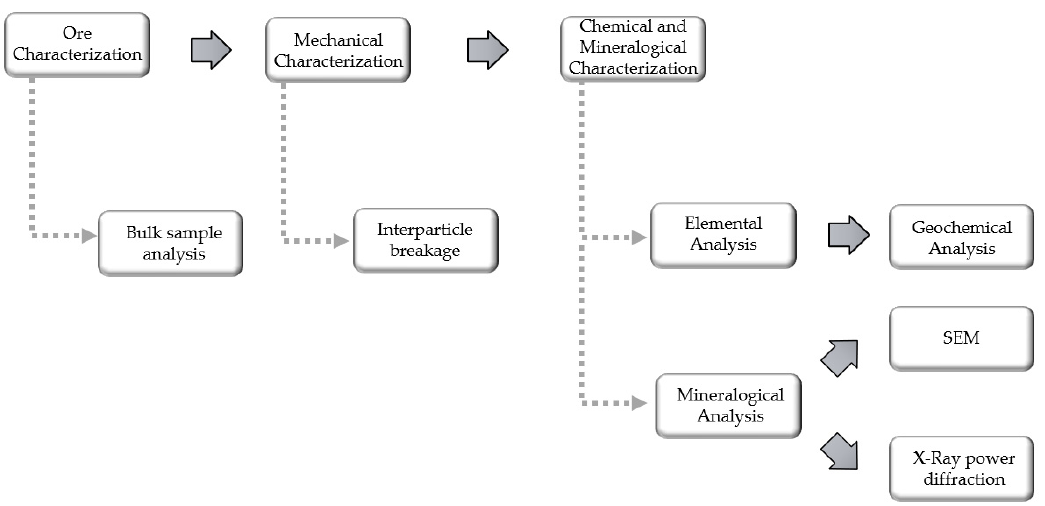
Figure 1. Method for analyzing the mineral and element composition in compression breakage .